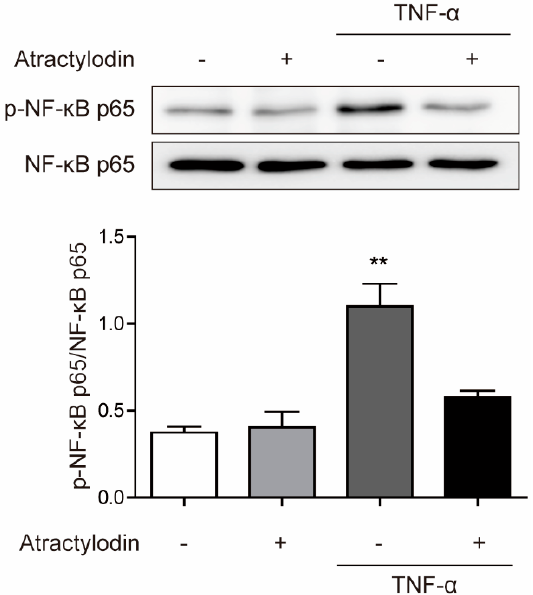
Figure 2. Inhibitory effects of atractylodin against TNF- α -induced NF- κ B phosphorylation. HCT116 cells were pretreated with atractylodin (50 μ M) for 1 h followed by TNF- α (5 ng/mL) treatment for 15 min. Protein expression were analyzed by immunoblotting analysis. ** p < 0.01 compared to the untreated control.